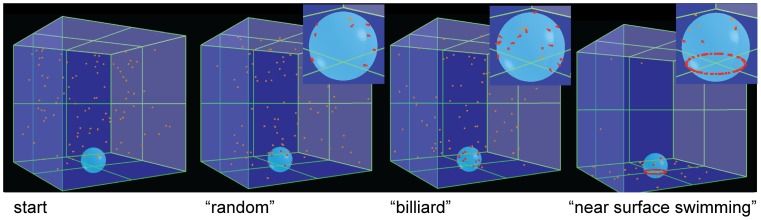
Simulation of S. Typhimurium targeting to physical obstacles.(A) To simulate S. Typhimurium targeting to physical obstacles, a round “cell” (light blue sphere) and linearly moving “bacteria” (orange particles) were modeled in an in silico experiment. If during the simulation a bacterium hits the sphere, it is either deflected or has a 10% chance of remaining at that site (“stopping”, red particles). Behavior of particles on the base of the cage ( = “surface”) and upon hitting the sphere if no docking occurred differed according to the respective scenario: Reflection with a random angle in the “random” scenario, with an angle of reflection identical to the angle of the impact in the “billiard” scenario and no reflection but movements following the surface of the object in the “NSS” scenario. The start of the simulation is depicted in the far left. Inserts show an enlarged view of the area around the sphere.